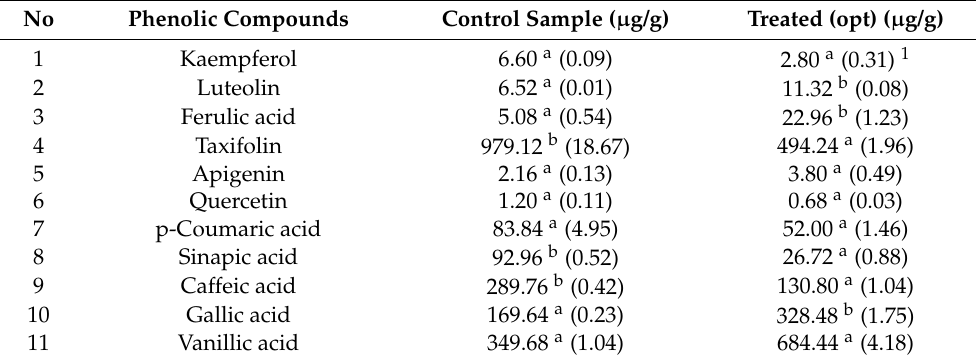
Table 6. Individual free phenolic compounds ( µ g/mL) identified in the extracts of cowpea processed at optimized